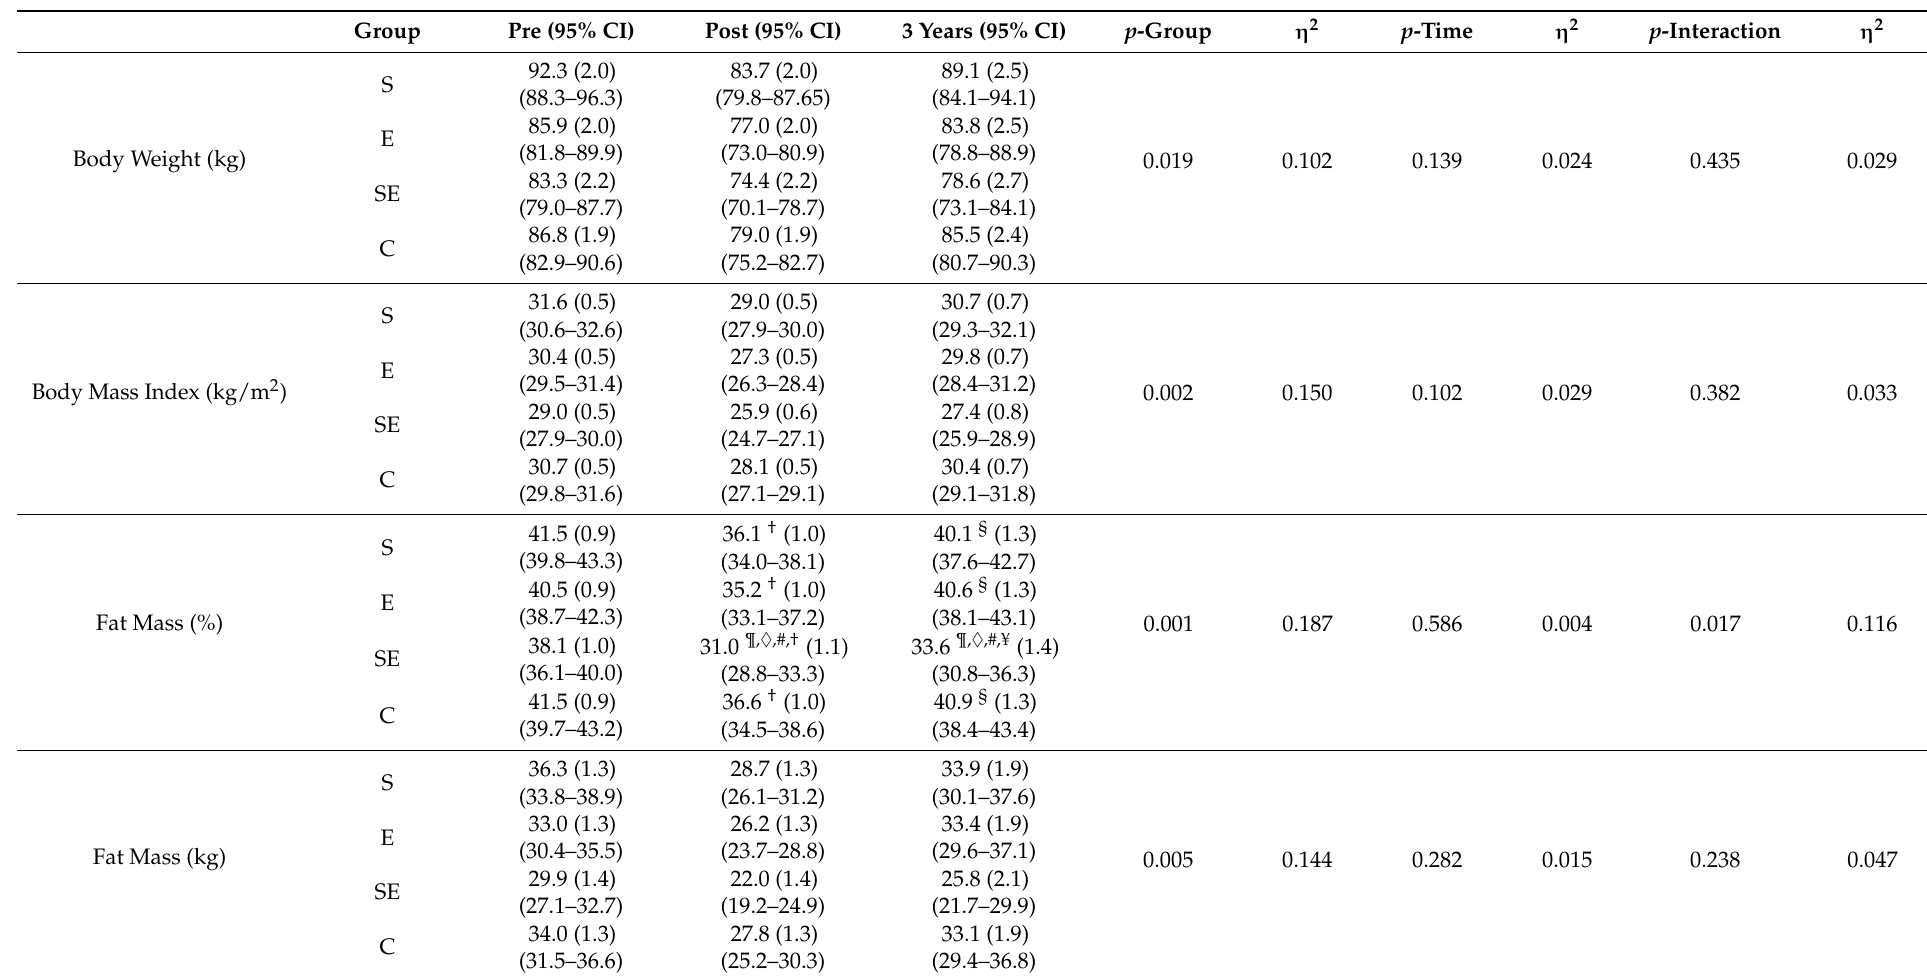
Table 1. Values of body composition variables at pre-intervention, post-intervention, and 3 years after. Presented as mean (standard error of mean) at 95% CI.